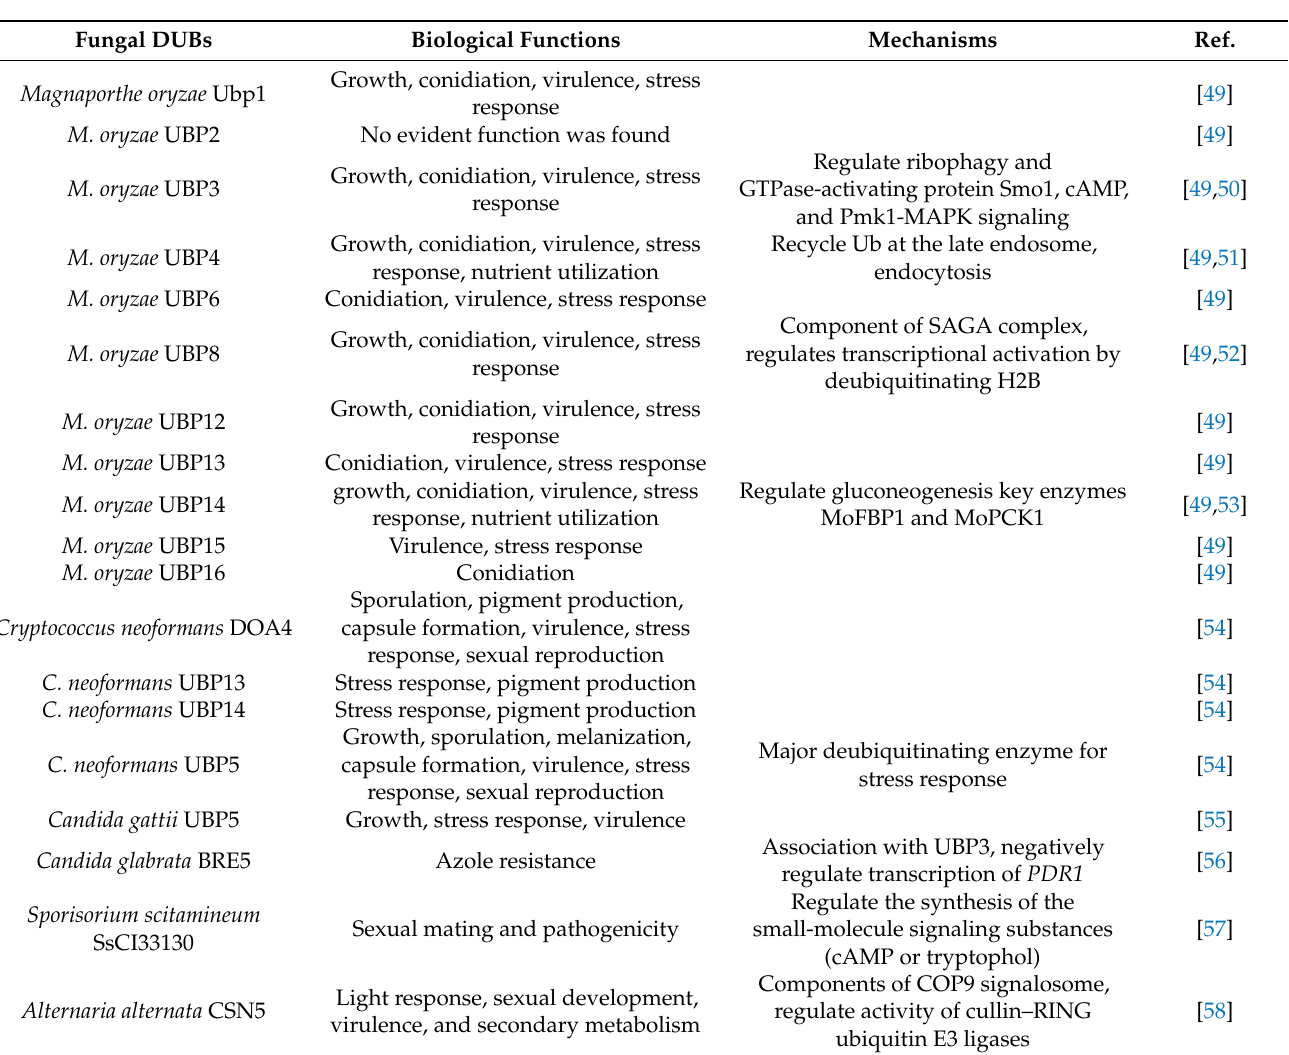
Table 2. Fungal DUBs and their